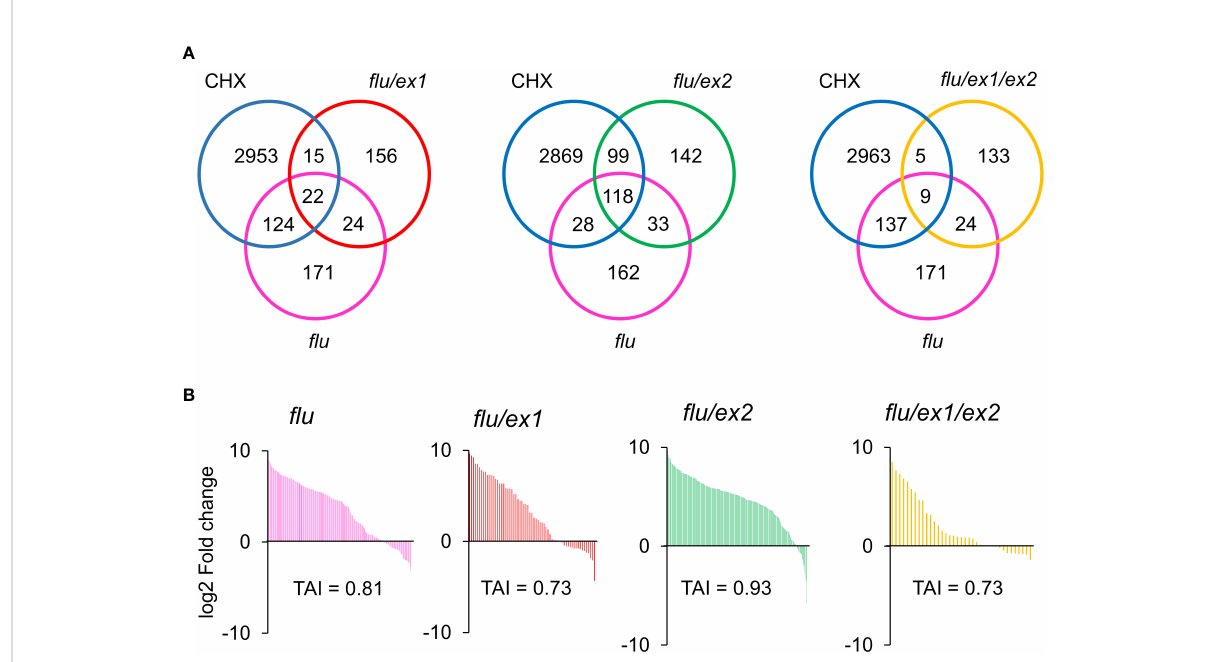
FIGURE 6 Venn diagram and Translational Attenuation Index analysis of fl u, fl u/ex1, fl u/ex2, fl u/ex1/ex2 transcriptomes. (A) Venn diagram overlaps of 2- fold up-regulated (p < 0.05) genes of CHX, fl u , fl u/ex1 , fl u/ex2 , fl u/ex1/ex2 . (B) Translational Attenuation Index analysis of CHX, fl u , fl u/ex1 , fl u/ ex2 and fl u/ex1/ex2 induced transcripts. Genes from fl u , fl u/ex1 , fl u/ex2 , fl u/ex1/ex2 transcriptomes as in (A) were screened against a dataset of cycloheximide treatment and their expression values under cycloheximide treatment are displayed accordingly. The data from CHX, fl u , fl u/ex1 , fl u/ex2 and fl u/ex1/ex2 were obtained from public databases. (CHX – GSE111284; fl u , fl u/ex1 , fl u/ex2 and fl u/ex1/ex2 –